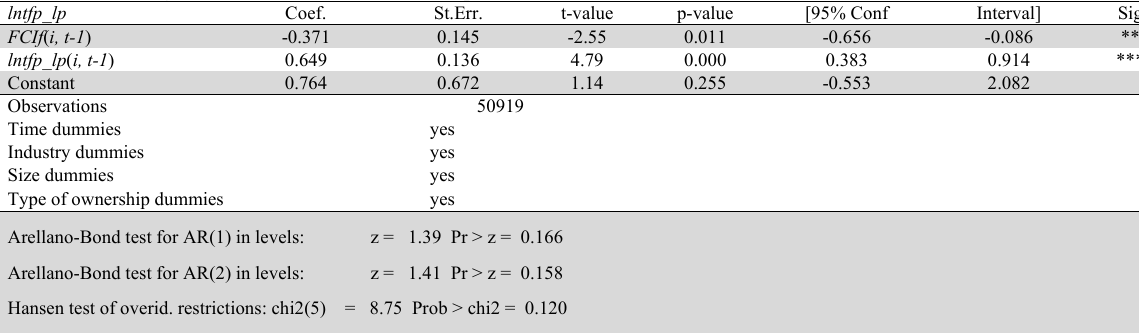
The effects of FCIf on TFP (GMM estimation on panel data) lntfp_lp